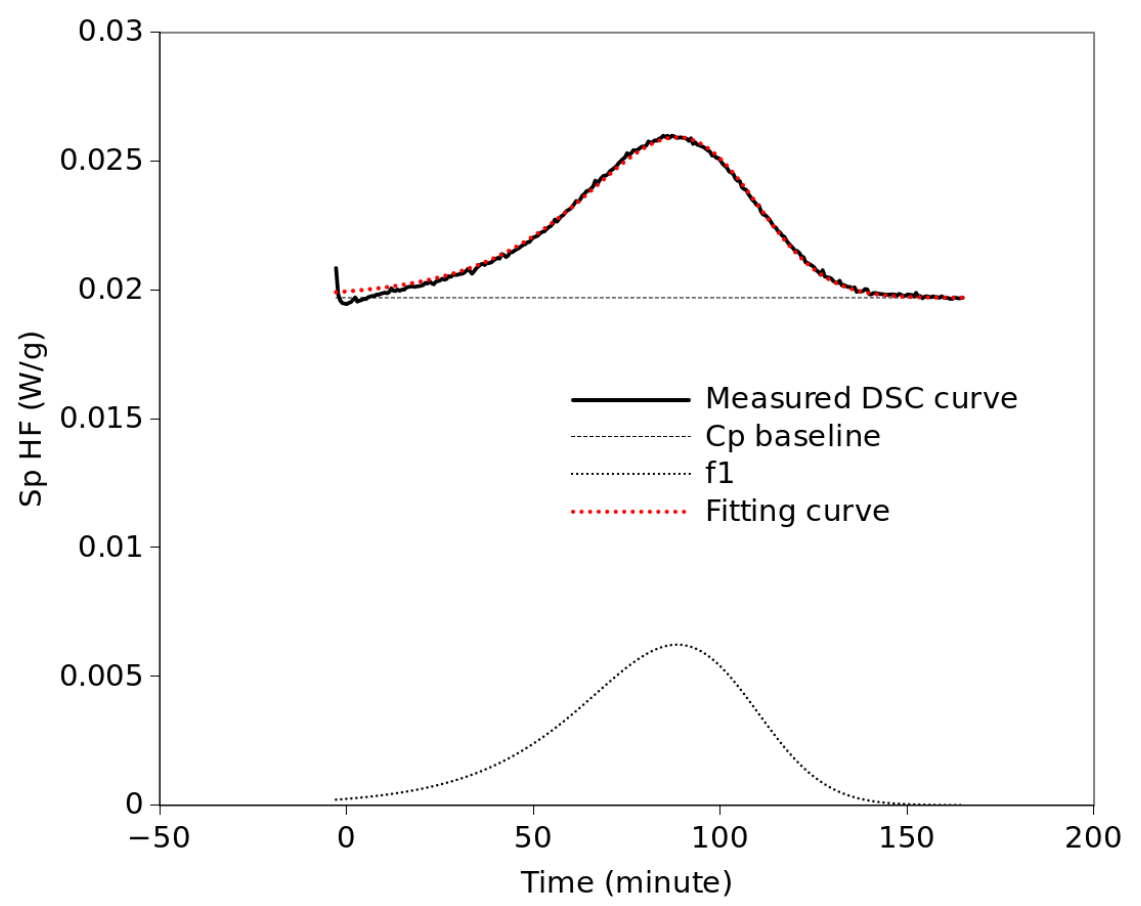
Figure 5. Fitting of a DSC curve by a single TDGL function.